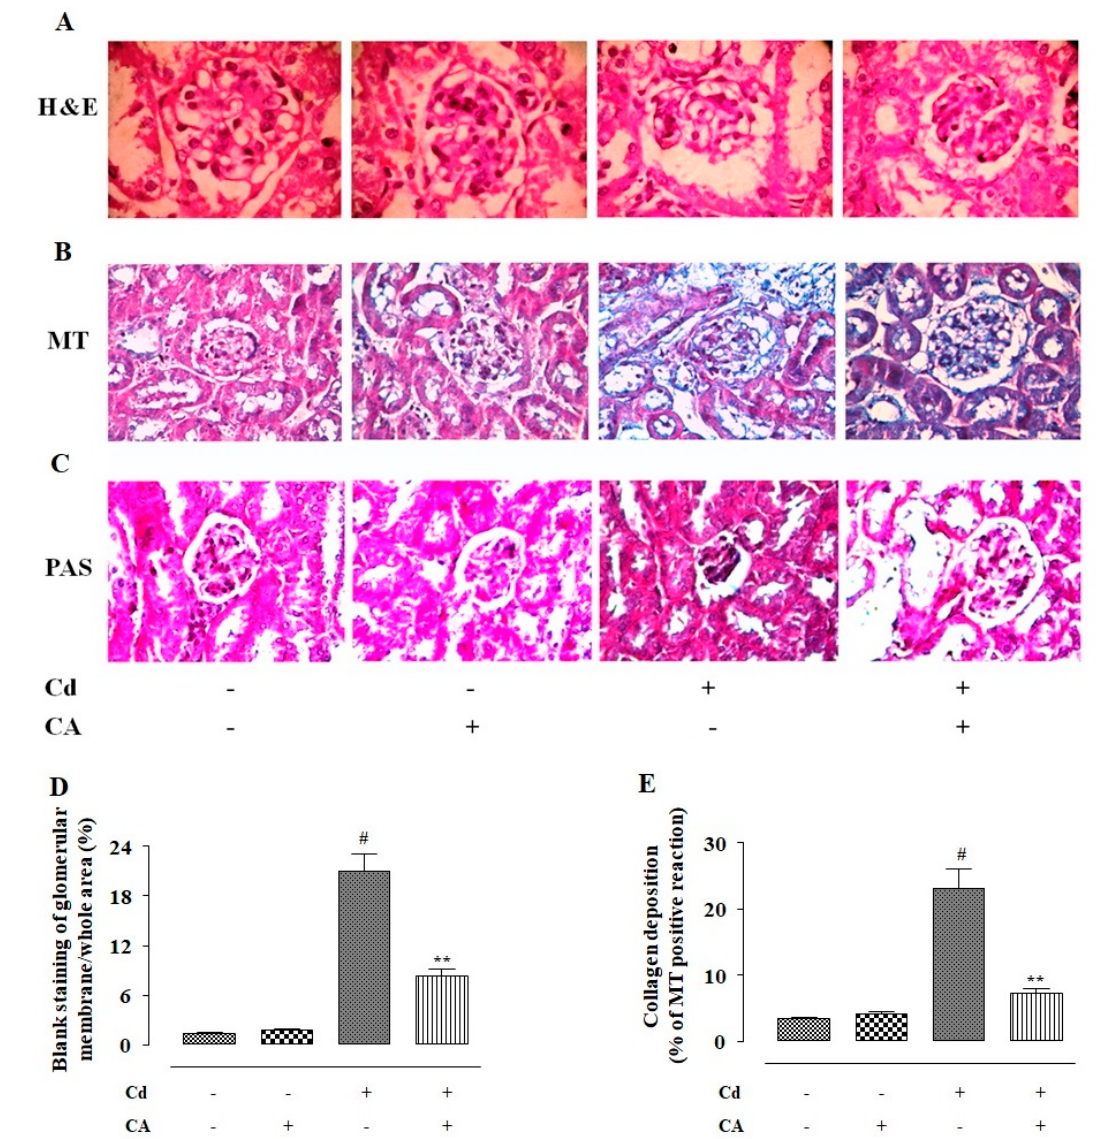
Figure 9. The effects of CdCl 2 and/or CA on the histological structures of mouse kidneys. ( A ) Haematoxylin and eosin (H and E)-stained sections of mice kidneys (×400). ( B ) The Masson’s trichrome (MT)-stained sections of mice kidneys (×400). ( C ) The PAS-stained sections of mice kidneys (×400). ( D ) The widening of capsular space was shown as a percentage of the blank staining of glomerular membrane compared to the whole area of the H and E-stained photomicrograph (×400, arbitrarily selected areas containing one glomerulus). ( E ) Histo-quantification of collagen deposition in MT-stained kidney sections. Data are represented as the mean ± SD, n = 6 × 5. Five randomly selected portions containing a glomerulus from a kidney section of each mouse were chosen for histoquantification. # Values significantly ( p < 0.01) differed from the vehicle-treated group. ** Values significantly ( p < 0.01) differed from only the CdCl 2 -treated group.